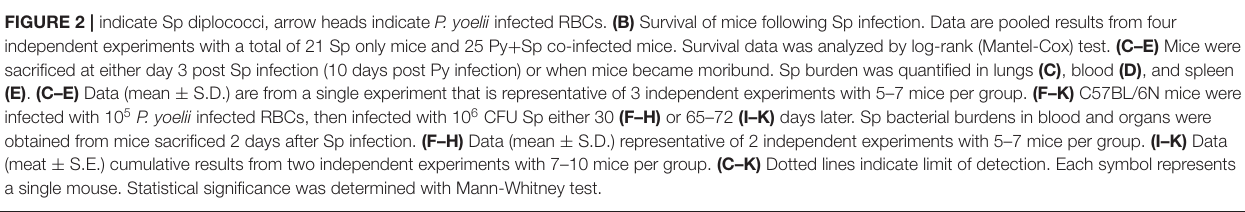
FIGURE 2 | indicate Sp diplococci, arrow heads indicate P. yoelii infected RBCs. (B) Survival of mice following Sp infection. Data are pooled results from four independent experiments with a total of 21 Sp only mice and 25 Py + Sp co-infected mice. Survival data was analyzed by log-rank (Mantel-Cox) test. (C–E) Mice were sacrificed at either day 3 post Sp infection (10 days post Py infection) or when mice became moribund. Sp burden was quantified in lungs (C) , blood (D) , and spleen (E) . (C–E) Data (mean ± S.D.) are from a single experiment that is representative of 3 independent experiments with 5–7 mice per group. (F–K) C57BL/6N mice were infected with 10 5 P. yoelii infected RBCs, then infected with 10 6 CFU Sp either 30 (F–H) or 65–72 (I–K) days later. Sp bacterial burdens in blood and organs were obtained from mice sacrificed 2 days after Sp infection. (F–H) Data (mean ± S.D.) representative of 2 independent experiments with 5–7 mice per group. (I–K) Data (meat ± S.E.) cumulative results from two independent experiments with 7–10 mice per group. (C–K) Dotted lines indicate limit of detection. Each symbol represents a single mouse. Statistical significance was determined with Mann-Whitney